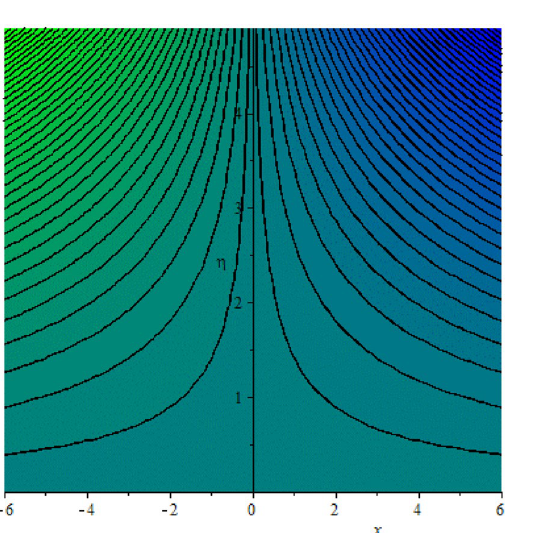
Figure 13. Stream lines when γ = 0.0 and β =